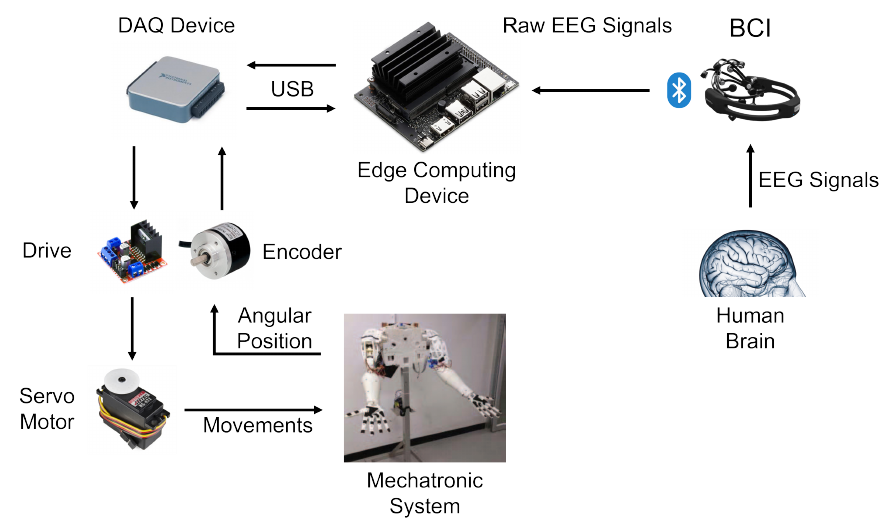
Figure 10. Suggested usage scenario for an application of mechatronic control